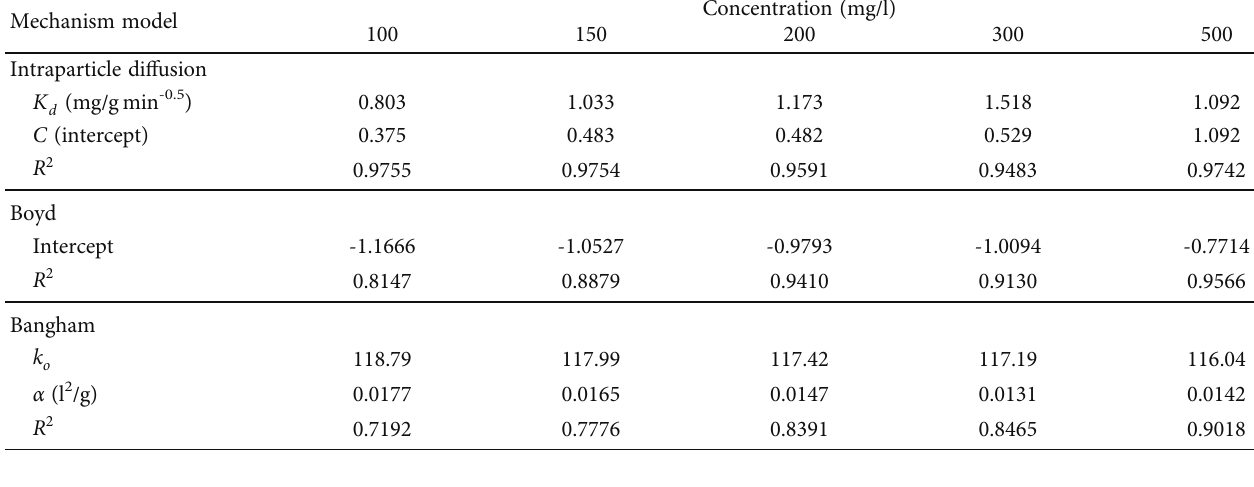
Table 7: Adsorption mechanism model parameters for phenol uptake onto TMCC.